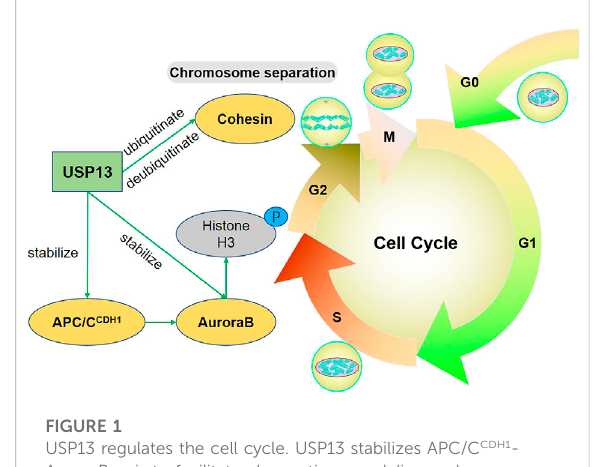
FIGURE 1 USP13 regulates the cell cycle. USP13 stabilizes APC/C CDH1 - AuroraB-axis to facilitate chromatin remodeling and condensation. Particularly, AuroraB functions by phosphorylating multiple proteins involved in the mitosis, such as Histone H3. Cohesin is ubiquitinated by USP13 to help sister chromosome separation during mitosis and simultaneously USP13 can also deubiquitinate and stabilize Cohesin. Green arrow indicates